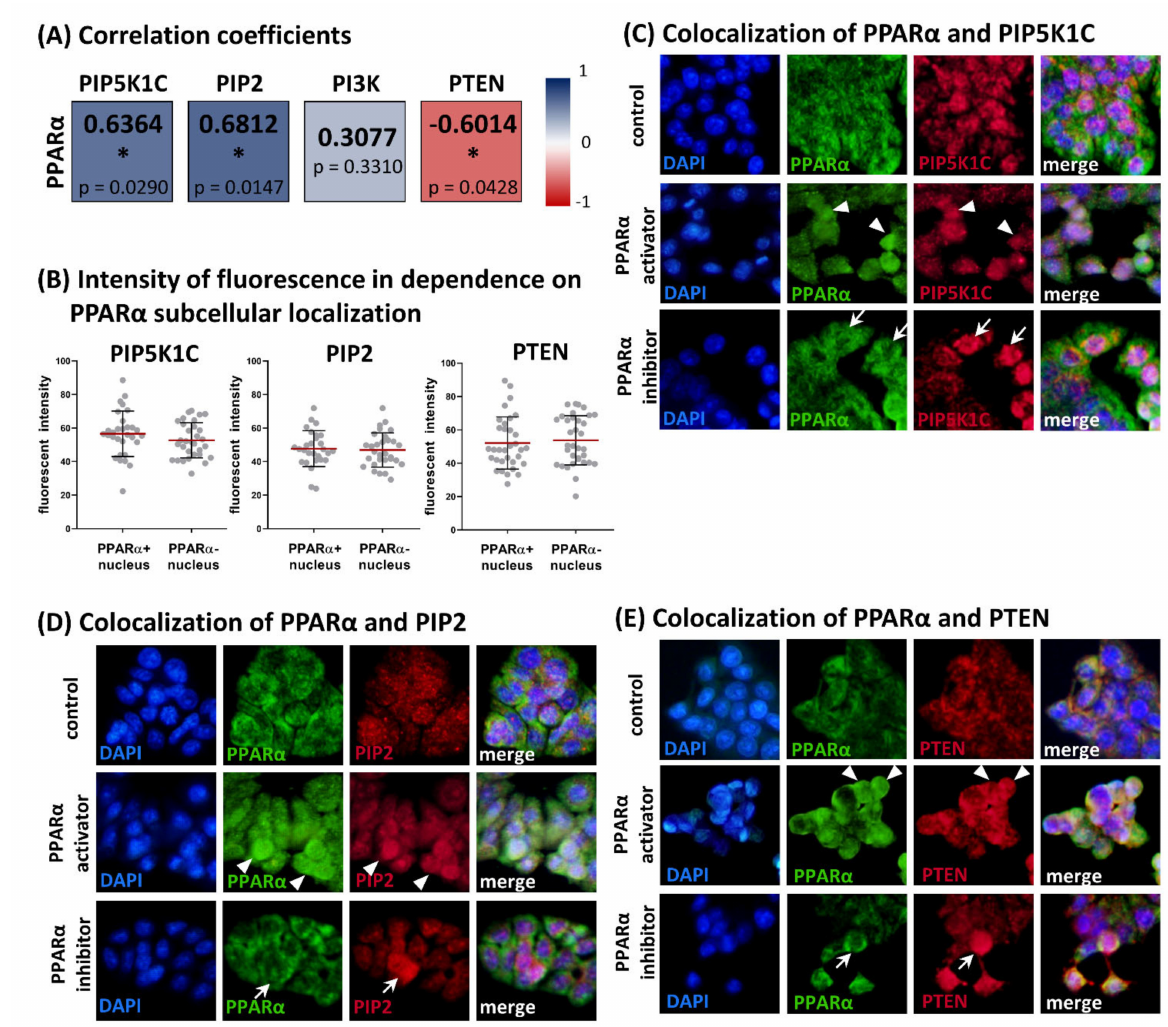
Figure 2. Relationships between levels of PPAR α and PIP5K1C, PIP2, PI3K, and PTEN in HT-29 cell line. ( A ) Spearman correlation coefficients ( n = 12) for expression levels obtained with In-Cell ELISA method. PPAR α expression under the same experimental condition was examined in our previous study [18]. Moderate positive correlations were found between PPAR α and PIP5K1C and PPAR α and PIP2, whereas PPAR α and PTEN expression showed moderate negative correlation (statistical significance marked with asterisk, * p ≤ 0.05) ( B ) Intensities of PIP5K1C, PIP2, and PTEN immunofluorescent staining for dependence of PPAR α subcellular localization. Fluorescent intensities of PIP5K1C, PIP2 and PTEN were measured using ImageJ software. Note that intensities of fluorescence are at the same levels in cells with nucleus positive for PPAR α and cells with PPAR α negative nucleus (unpaired t -test, nonsignificant results, n = 30 in each group). Colocalization of PPAR α and PIP5K1C ( C ), PIP2 ( D ), and PTEN ( E ). The cells were treated by 150 µ M fenofibrate (PPAR α activator) and 10 µ M GW6471 (PPAR α inhibitor), and controls were treated with appropriate amount of DMSO. Staining intensities of PIP5K1C, PIP2, and PTEN were independent of subcellular localization of PPAR α . White arrows indicate cells with PPAR α negative nuclei together with strong staining of PIP5K1C, PIP2, and PTEN. White arrow heads indicate cells with PPAR α positive nuclei together with intensive staining of PIP5K1C, PIP2, and PTEN. All microphotographs are in the same magnification (400 × ), white line represents 10 µ